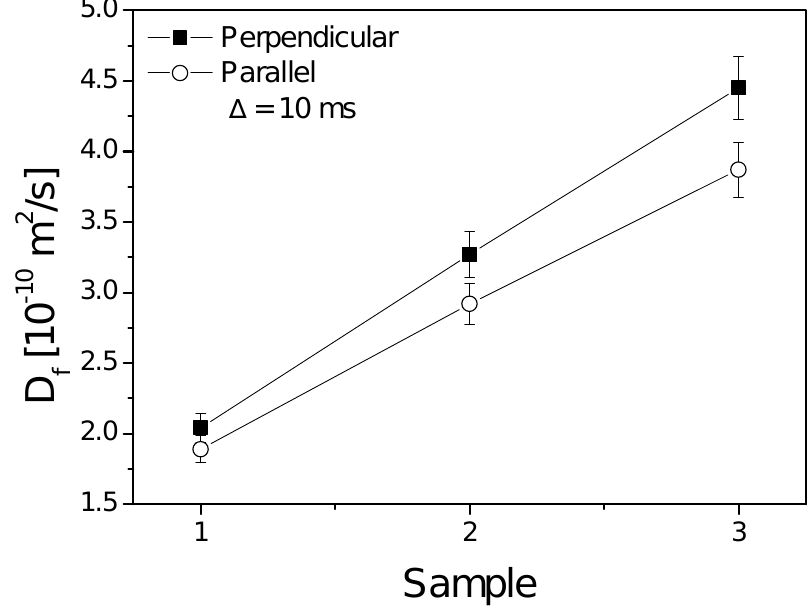
Figure 7. Water fast self-diffusion coefficients ( D fast ) of fully hydrated cSPEEK membranes with the magnetic field gradient parallel and perpendicular to the membrane plane. Sample code: Sample 1 = cSPEEK crosslinked at 150 °C for 60 min; Sample 2 = cSPEEK crosslinked at 200 °C for 30 min; and Sample 3 = cSPEEK crosslinked at 200 °C for 60 min.